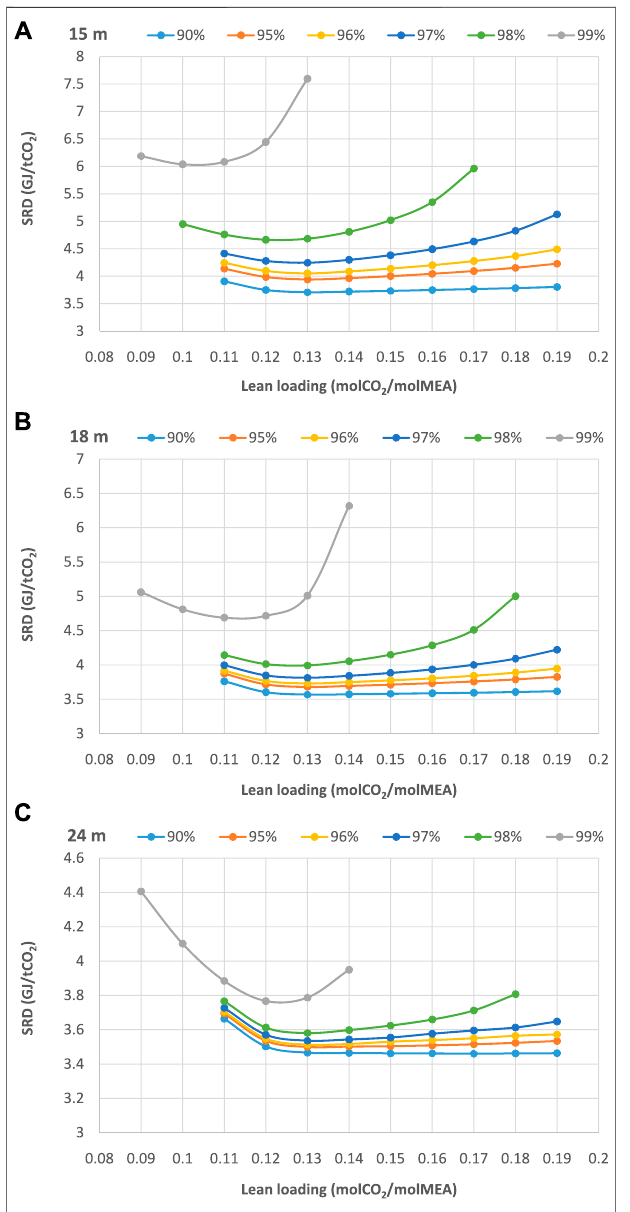
FIGURE 7 | Effect of lean loading on the speci fi c reboiler duty in the stripper for different absorber heights (a = 15 m, b = 18 m, c = 24 m) and various capture levels (note different vertical axis scales).